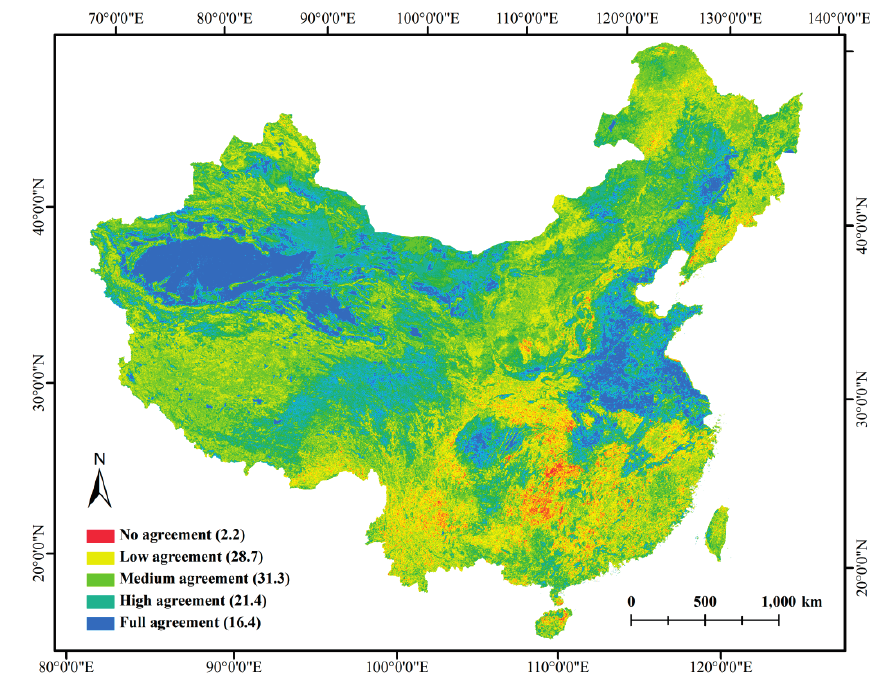
Figure 4. Spatial agreement among the five land cover data sets over China according to the aggregated legends. The number in brackets refers to the statistical percentage of the area coverage for corresponding agreement levels.